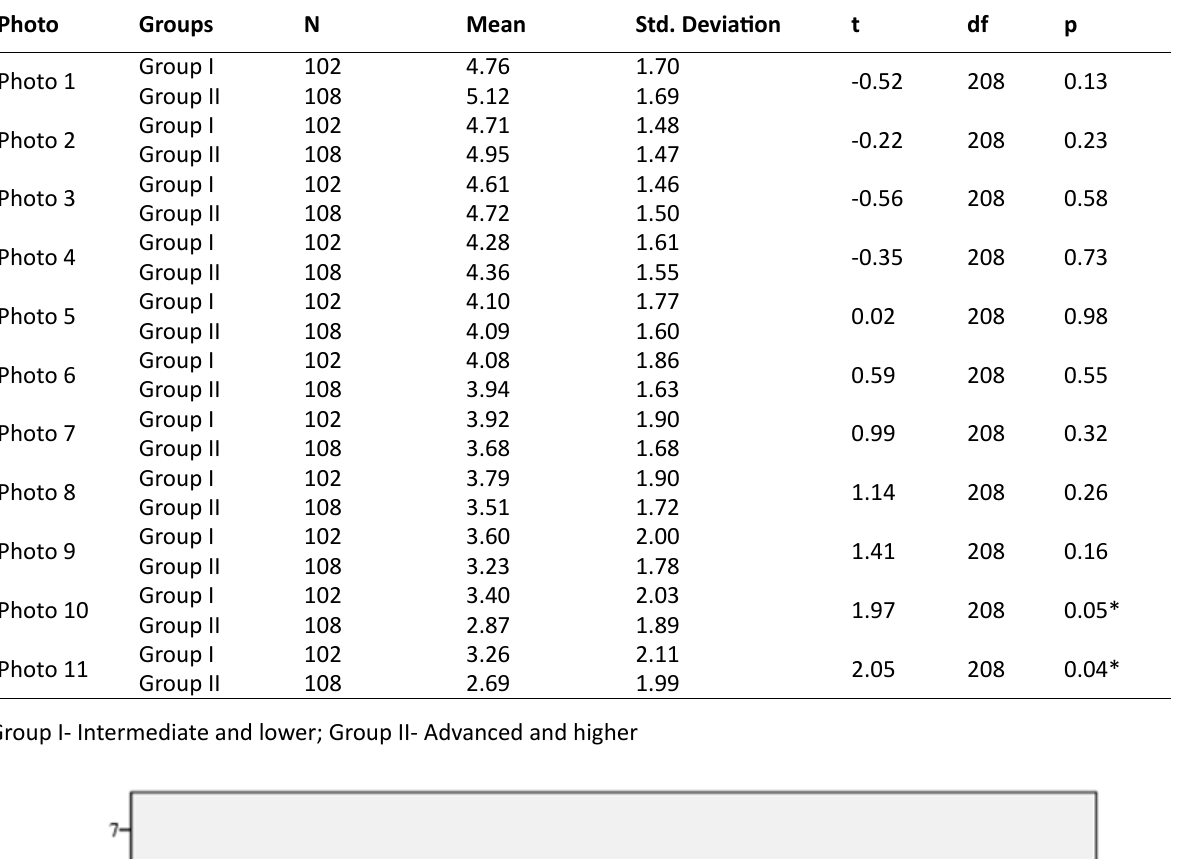
Table 3. Results of Independent Group t-test conducted for determining if the perceived visual quality of participators changed according to the climbing level